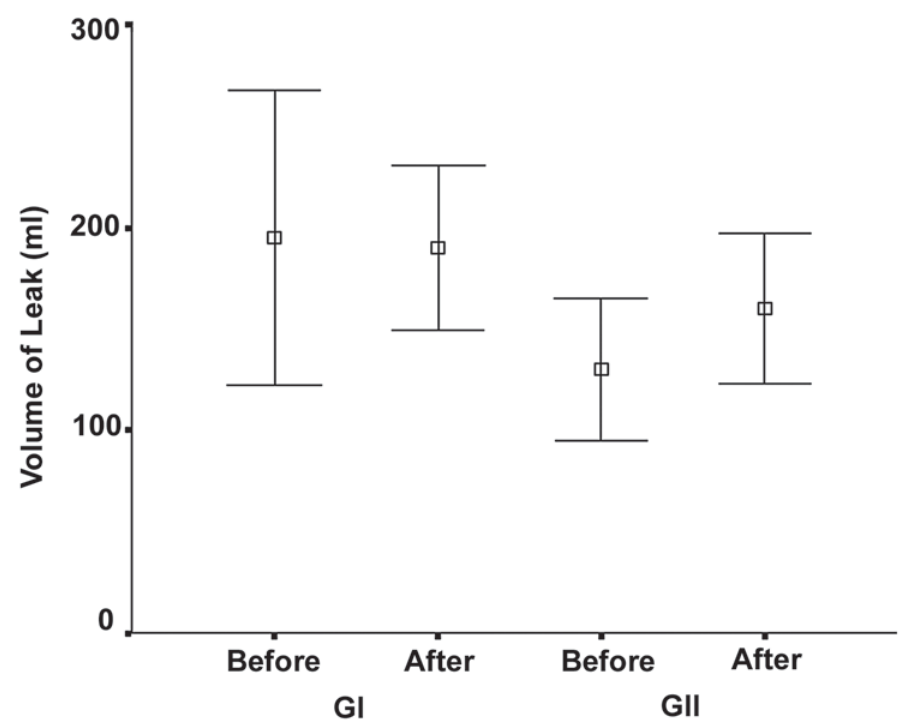
Figure 5 – Volume of leakage before and after treatment with periurethral injections. GI (Before X After): Anova – p > 0.05, GII (Before X After): Anova – p < 0.05